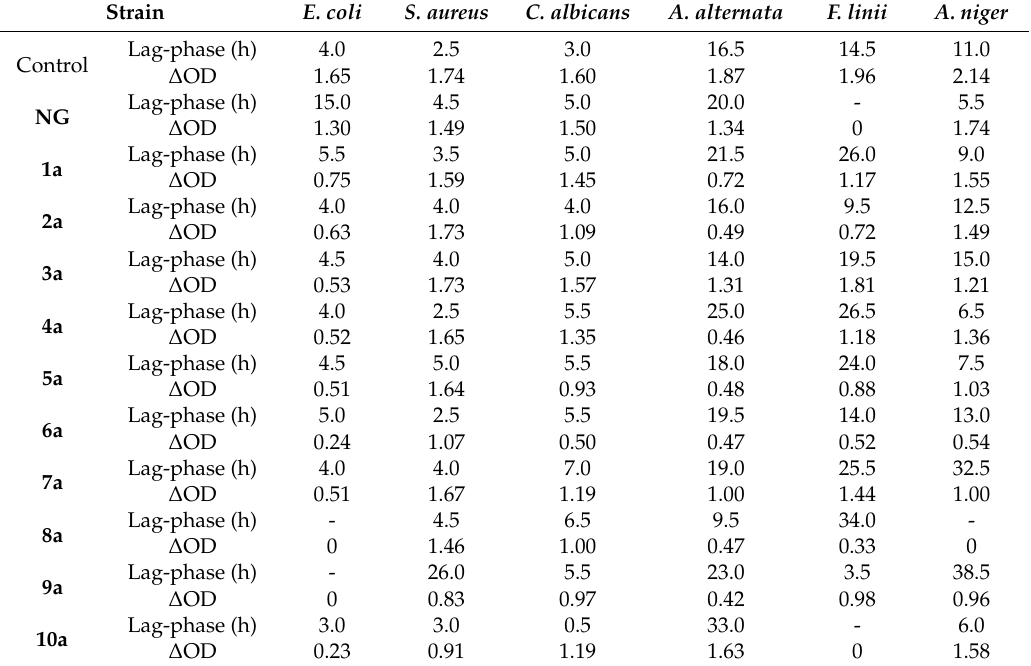
Table 1. Antimicrobial activity of O -alkyl derivatives of naringenin 1a – 10a .